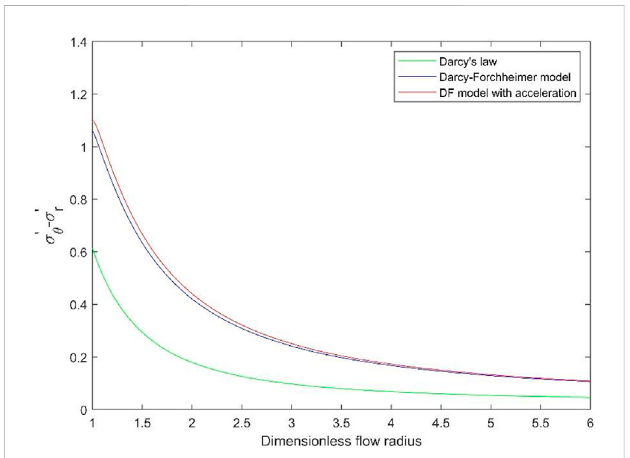
FIGURE 2 Difference between effective circumferential stress and effective radial stress for the three fl ow models.